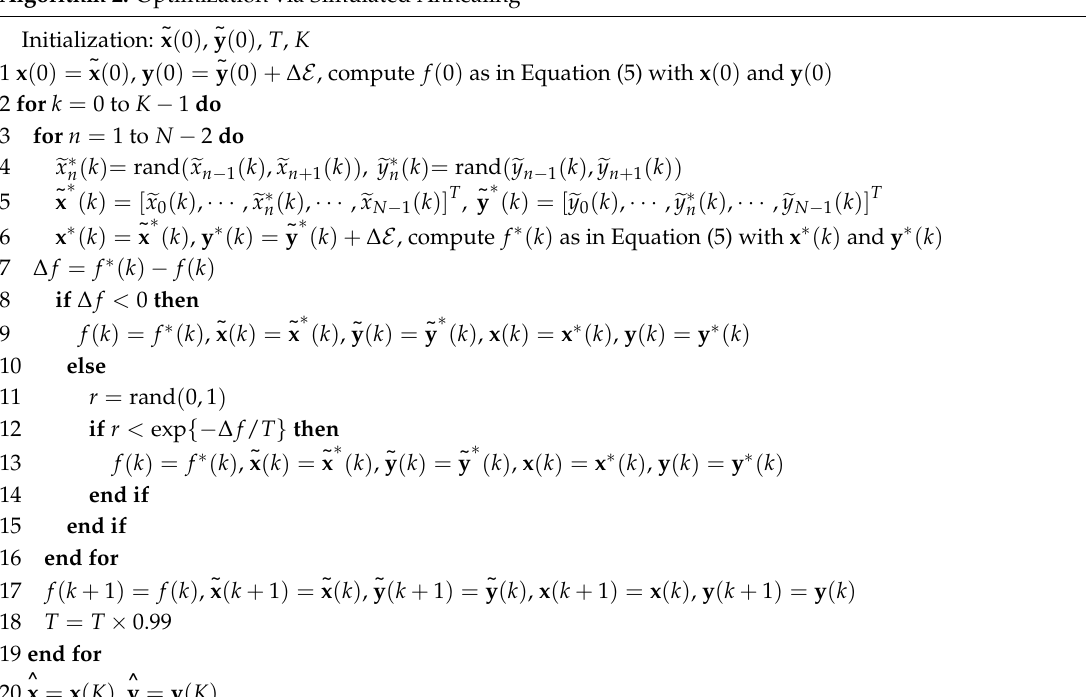
Algorithm 2. Optimization via Simulated